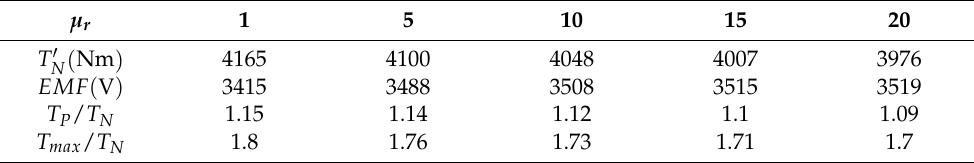
Table 3. Motor electromagnetic performance for different MSWs.